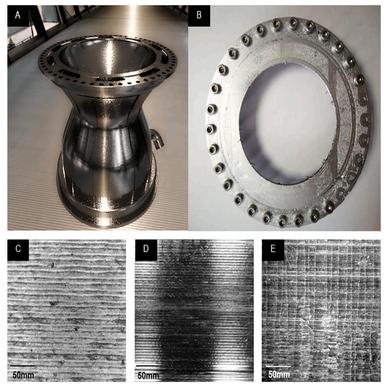
(A) Photograph of the final manufactured combustion chamber after CNC machining and polishing (B) photograph of a test gasket structure before machining and polishing (C) 100 μm surface roughness after first stage 5-axis CNC milling (D) 1000 μm surface roughness after second stage 5-axis CNC milling and (E) 2000 μm surface roughness after final stage 5-axis CNC milling.